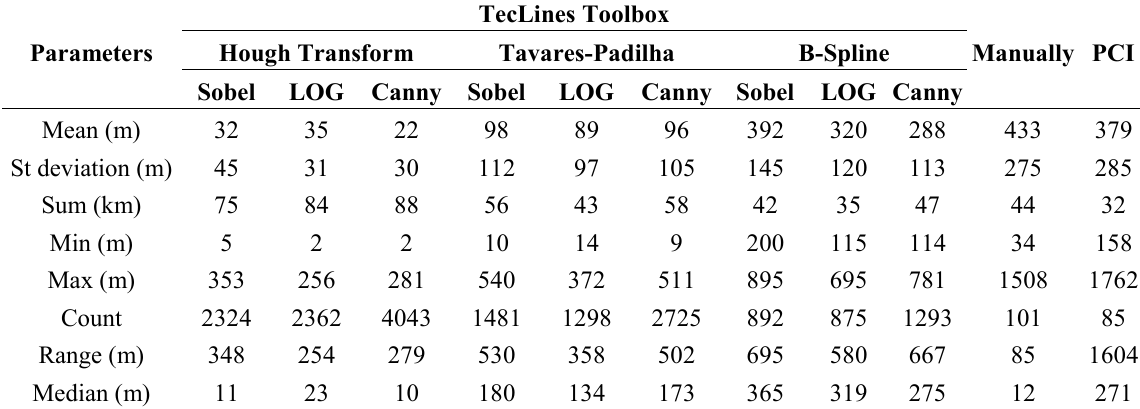
HT-derived line segments from three edge map sources demonstrate in Figure 12. The corresponding statistics are summarized in Table 2. Table 2. Statistics of extracted image discontinuities lenghts, which are derived from the three binary edge map sources (Sobel, LOG, and Canny) using TecLines, reference discontinuity map (manual extraction) and extracted using LINE module of the PCI Geomatica. Parameters